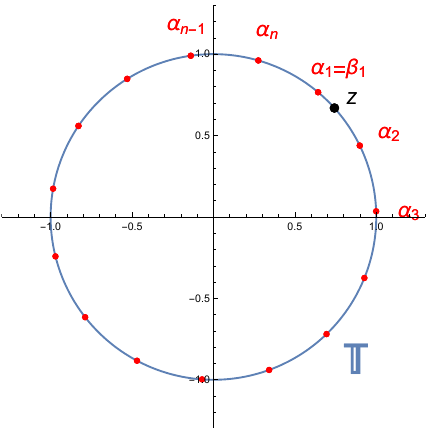
Figure 1. An arbitrary point z and the nodal